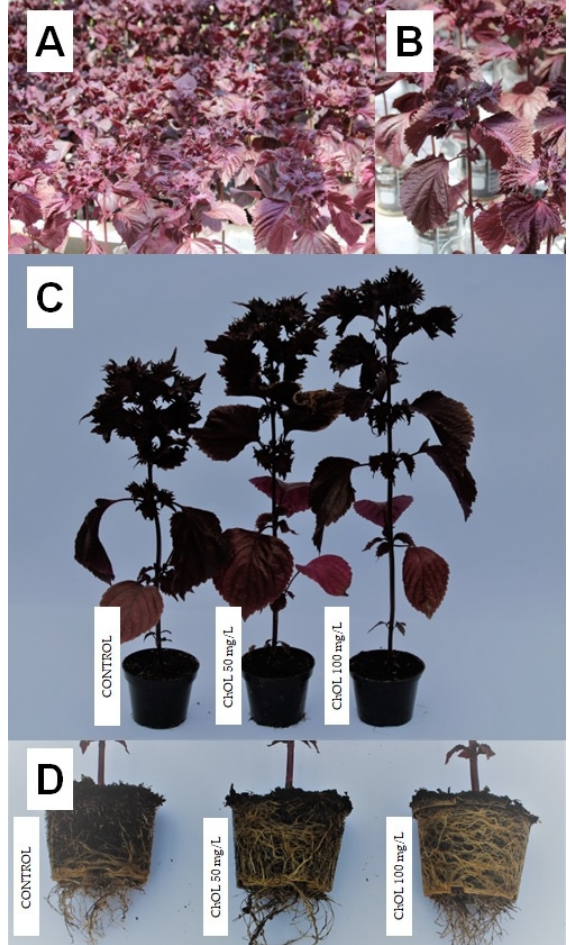
Figure 2. Effects of chitosan oligosaccharide lactate (ChOL) on plant growth of red perilla: ( A , B ) photograph of plants eight weeks after transplanting; ( C ) photograph of whole plants and ( D ) root system (left to right: nontreated control, 50 and 100 mg/L ChOL).